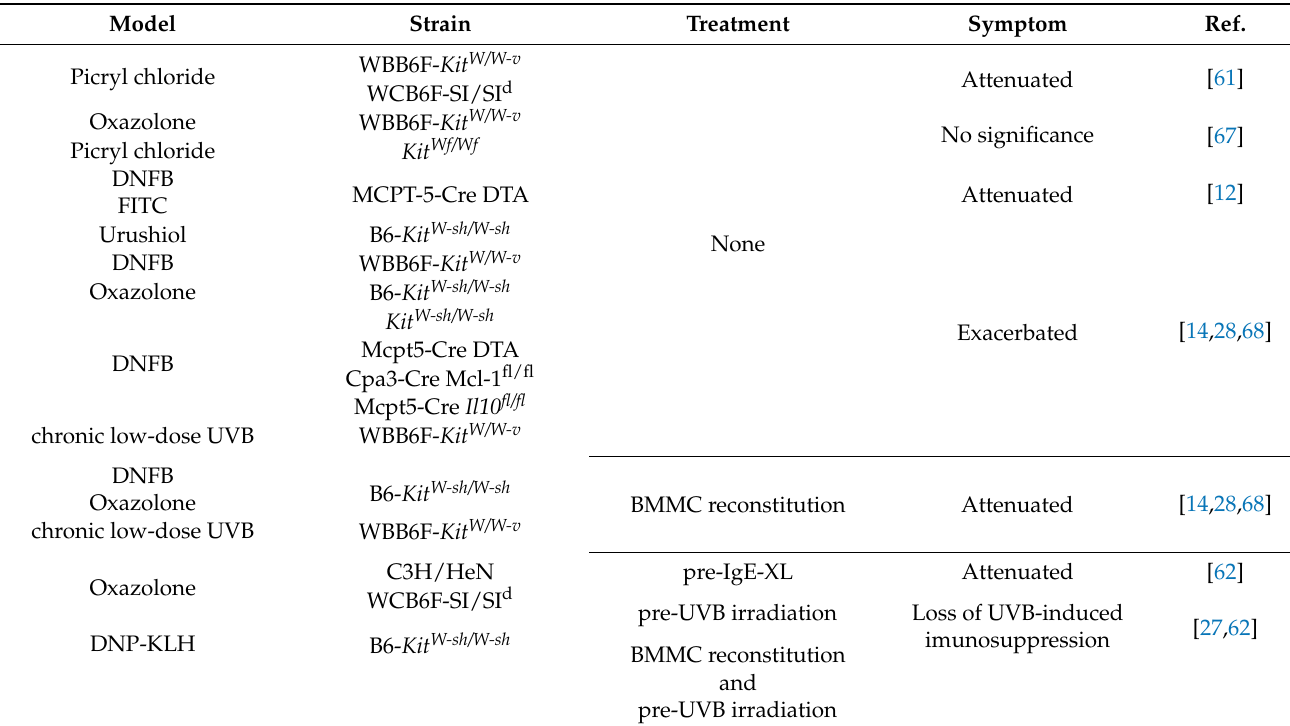
Table 3. Roles of MCs and/or IL-10 in skin